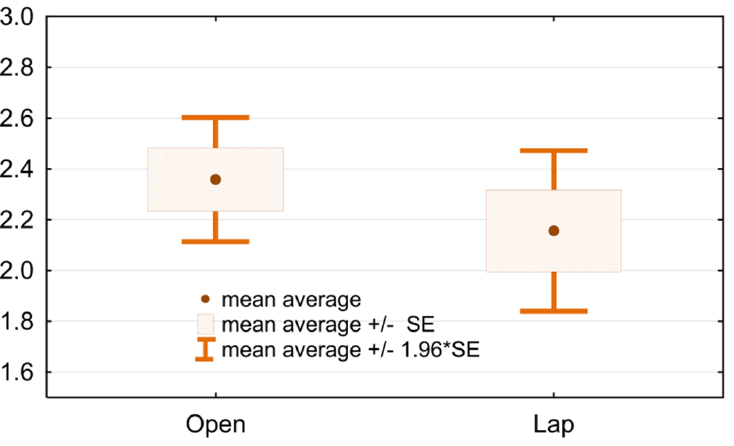
Figure 6. Mean degree of complications in the Clavien–Dindo scale ORC vs. LRC.